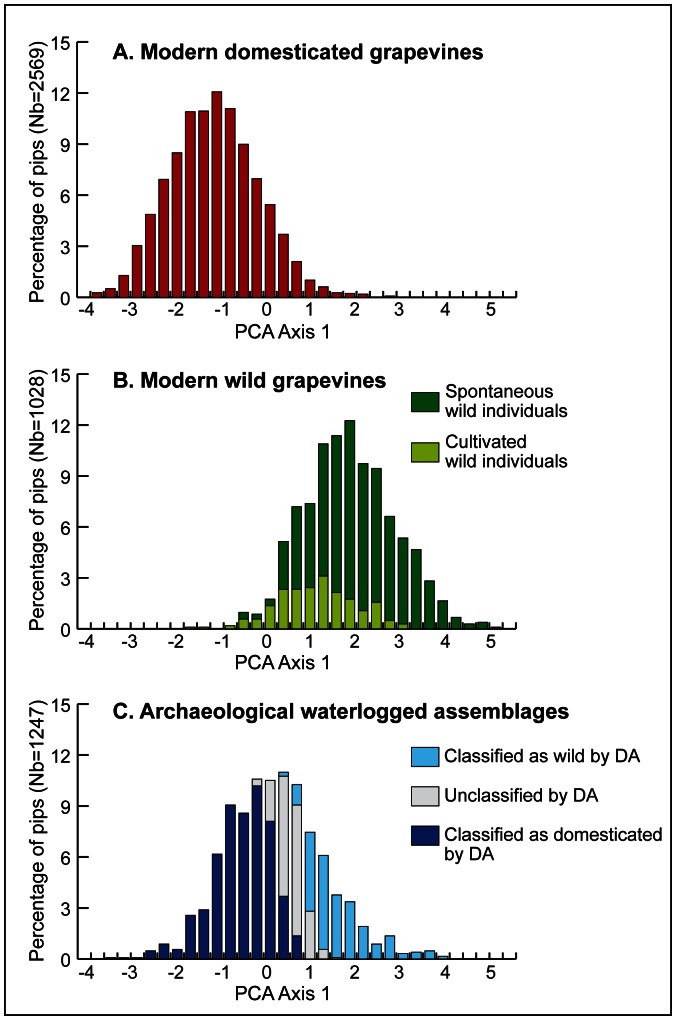
Comparison of modern domesticated and wild grapevines with Roman archaeobotanical assemblages of waterlogged pips.Archaeological pips are plotted as additional individuals in the PCA performed on modern individuals. The distribution of pips on PCA Axis 1 is represented as percentage values according to (A) modern domesticated grapevines (84 cultivars; 2569 pips), (B) modern spontaneous (29 individuals; 818 pips) and cultivated (7 individuals; 210 pips) wild grapevines, (C) archaeological assemblages (17 sites; 1247 pips). Additionally the classification of archaeological pips by DA as wild or domesticated (p value >0.75) is represented (C), see Table 4.